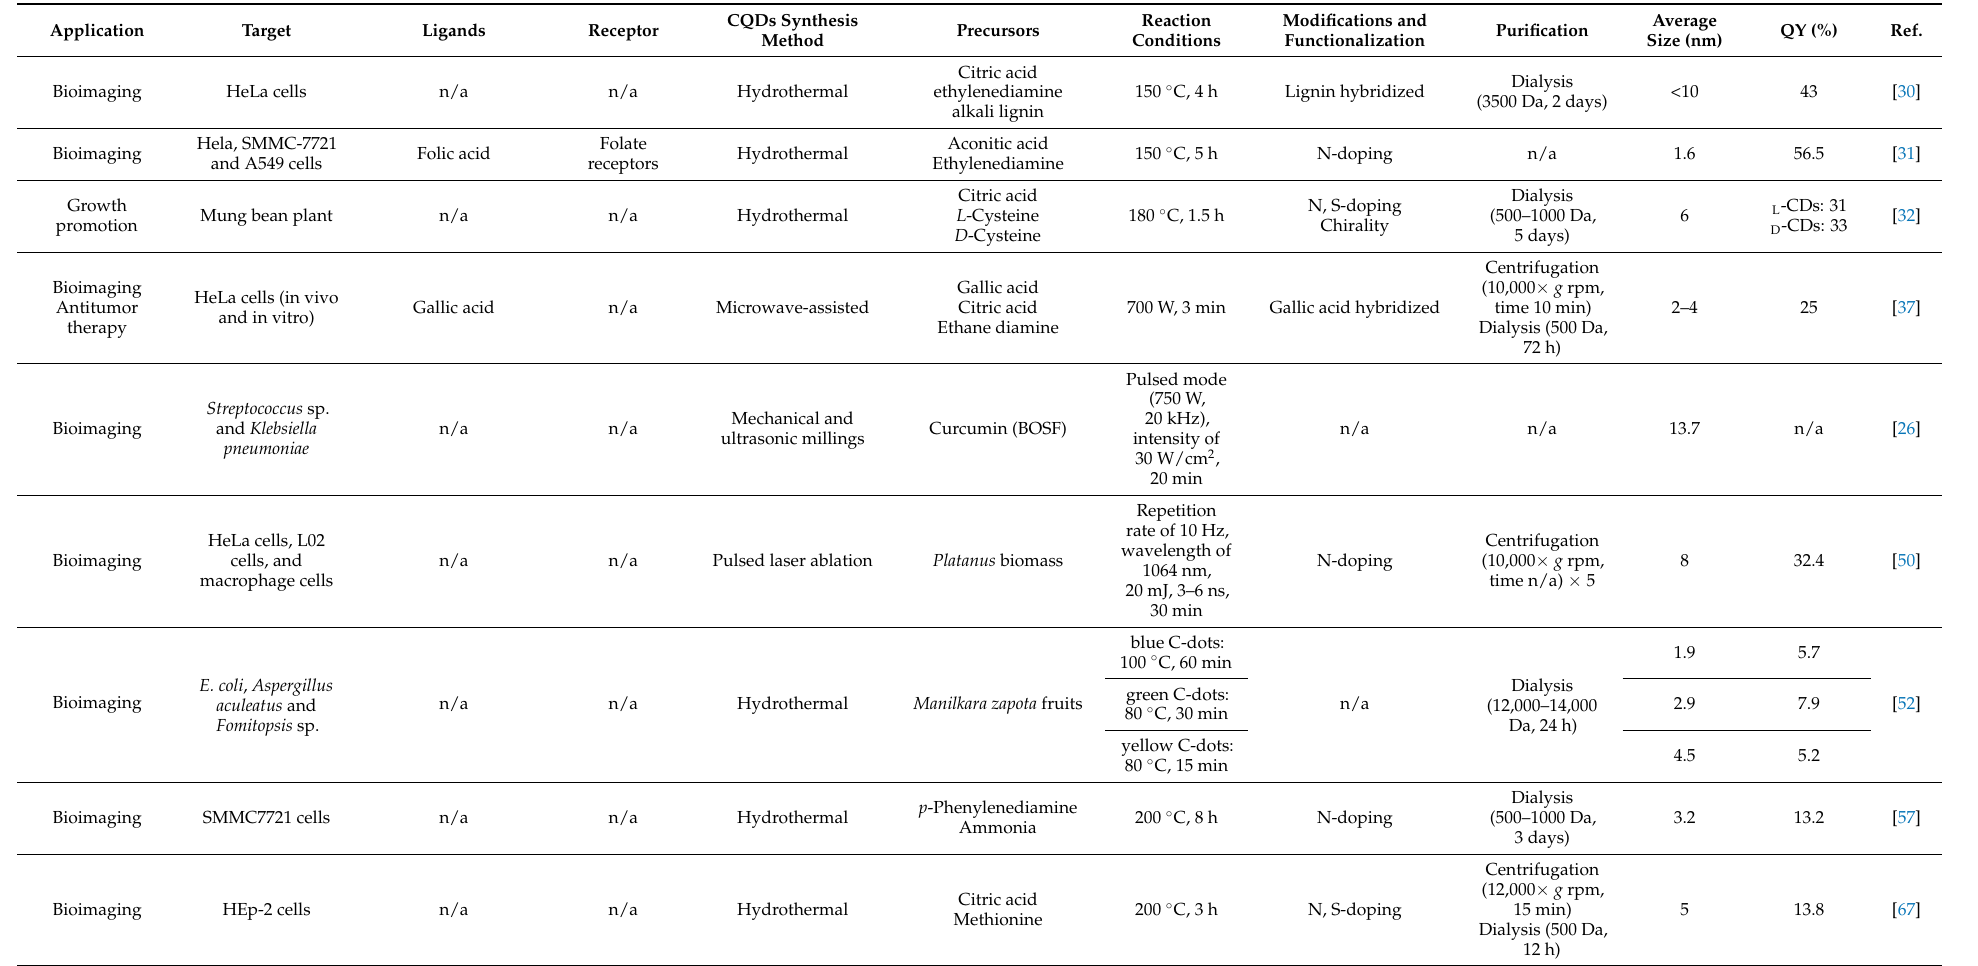
Table 3. Summarized examples of carbon quantum dots used for biomedical